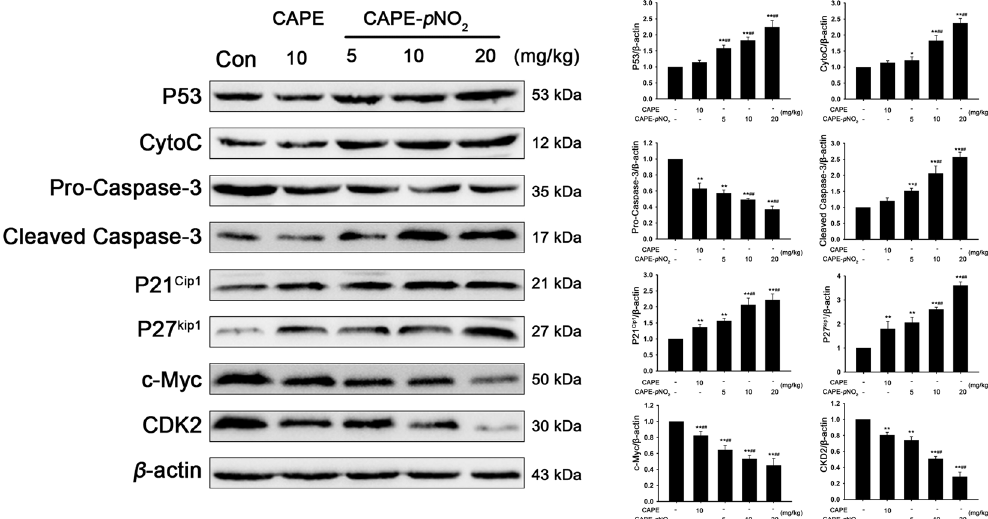
Figure 7. Regulation of proteins by CAPE and CAPE- p NO 2 treatment in in tumours. The regulations of P53, Pro-Caspase-3, Cleaved Caspase-3, CytoC, P21 Cip1 , P21 Kip1 , c-Myc and CDK2 in tumours were detected by western blotting. The blots were representative of three independent experiments. Data represented the means ± SD from three independent experiments, and error bars represented the STDEV (SD). * p < 0.05, ** p < 0.01: CAPE and CAPE- p NO 2 compared with the control. # p < 0.05, ## p < 0.01: CAPE- p NO 2 compared with CAPE at the same